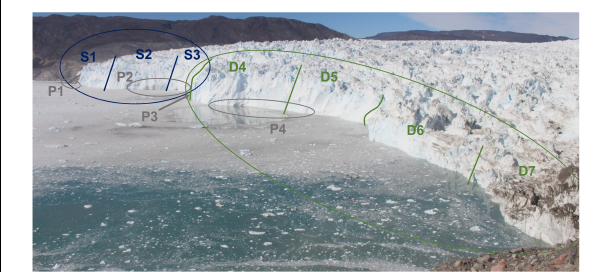
FIGURE 3 | Calving front sectors used in time-lapse image analysis are marked with lines. The sectors S1–S3 of the front correspond to the shallow sectors S and M (blue; S1, S2, S3) and the sectors D4–D7 to the deep sector D (green; D4, D5, D6, D7). The middle sector is hidden and thus included in the shallow sector S3. The approximate subglacial meltwater plume locations are indicated and named